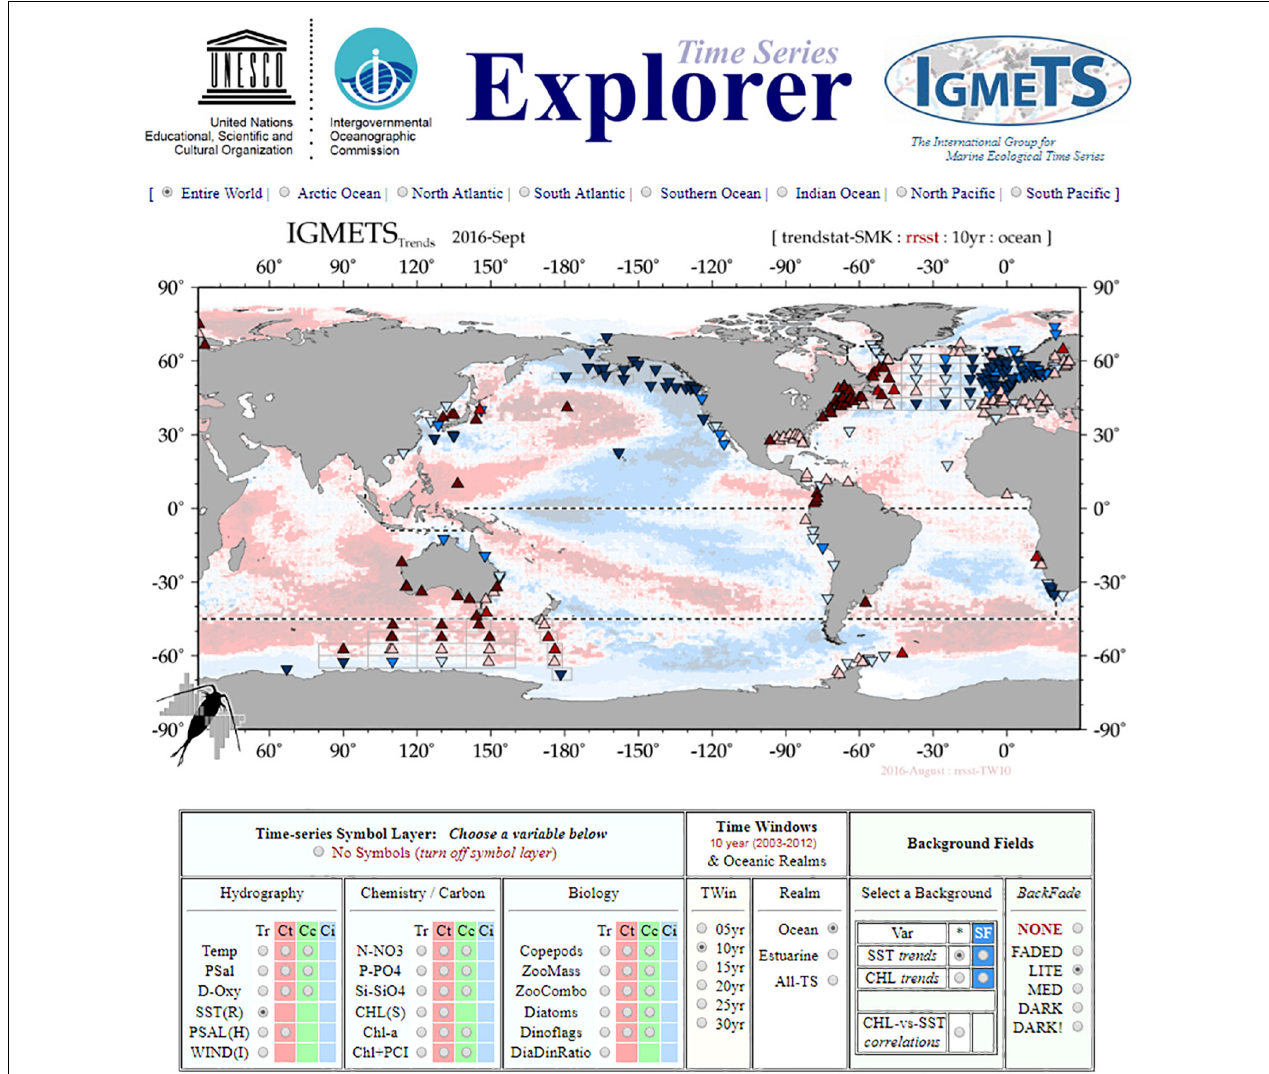
FIGURE 8 | Product highlights from the first International Group for Marine Ecological Time Series (IGMETS) study (O’Brien et al., 2017), which split the time series into the Explorer, which illustrates trends in different variables over time, and the Metabase, an interactive time series information and discovery tool. The next generation of IGMETS will combine Explorer and Metabase into a single tool that enables the user to find time series and preview their variables, trends, and background fields using a single interface rather than having to switch between two different